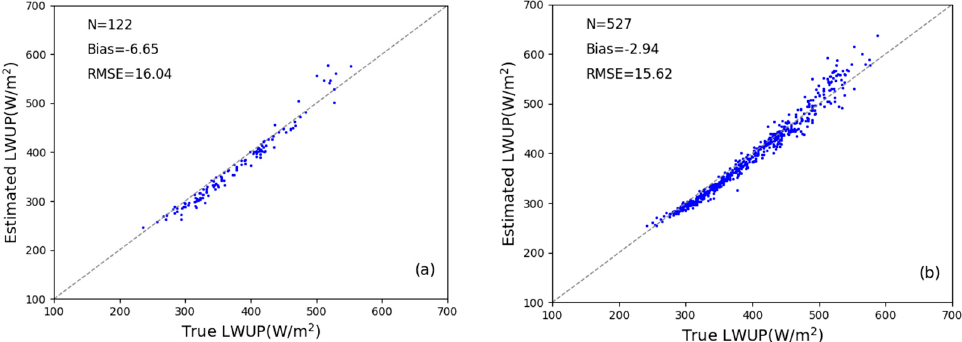
Figure 7. Validation results of the linear model at the Atmospheric Radiation Measurement (ARM) program Southern Great Plains (SGP) C1 site. ( a ) Pixels that were identified as clear sky by the VIIRS cloud mask whereas cloudy by ground-based Lidar; ( b ) pixels that were identified as clear sky by both the VIIRS Cloud Mask and the Lidar.